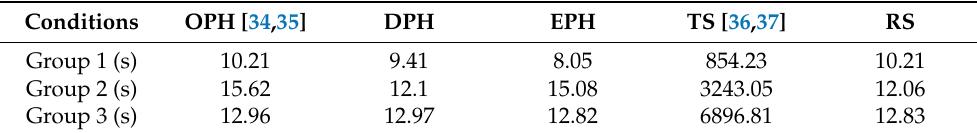
Table 5. The average calculation time of different methods in different